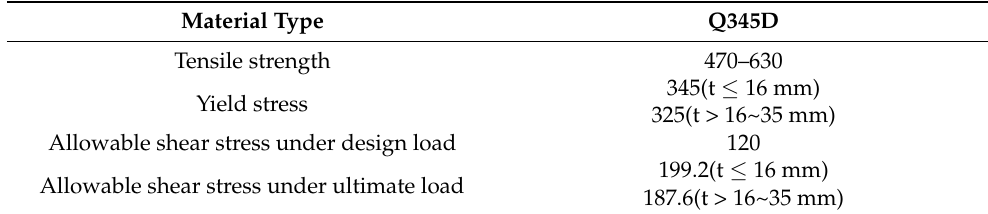
Table 2. Steel main beam and V-shaped pier modeling parameters.